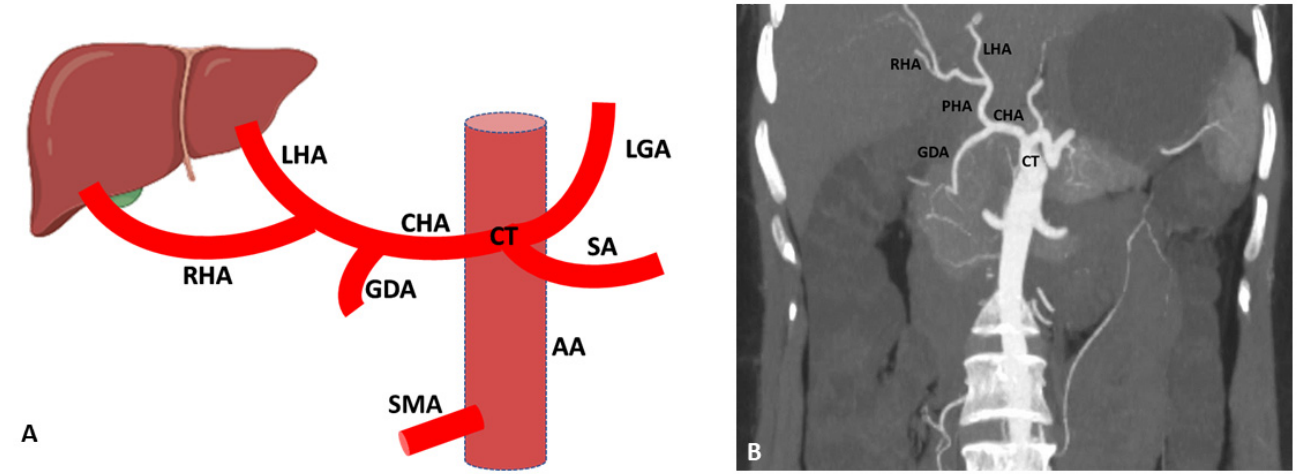
Figure 1. ( A ) Schematic representation of regular branching of the hepatic artery. ( B ) Coronal maximum intensity projection (MIP) (64-row scanner CT angiography) image of the abdominal region showing the regular anatomical branching pa tt ern of the hepatic artery. Slice thickness: 1.2 mm. AA: Abdominal aorta; CT: Celiac trunk; SA: Splenic artery; LGA: Left gastric artery; CHA: Common